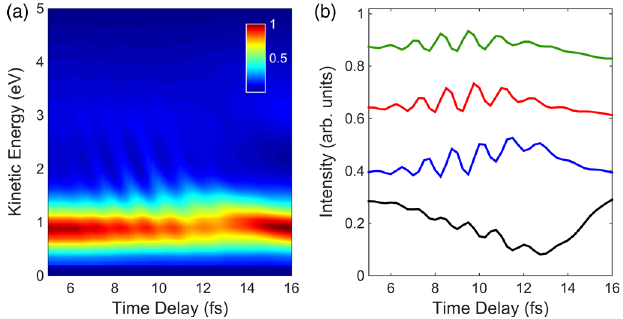
FIG. 5. (a) Time-dependent N þ kinetic energy spectra calcu- lated by including all states within the pump-probe delay interval 5 – 16 fs. (b) N þ yield integrated over a 0.3-eV-wide energy band around 0.8 eV (black curve), 1.6 eV (blue curve), 1.9 eV (red curve), and 2.2 eV (green curve). An arbitrary offset has been added to the curves for better visualization.